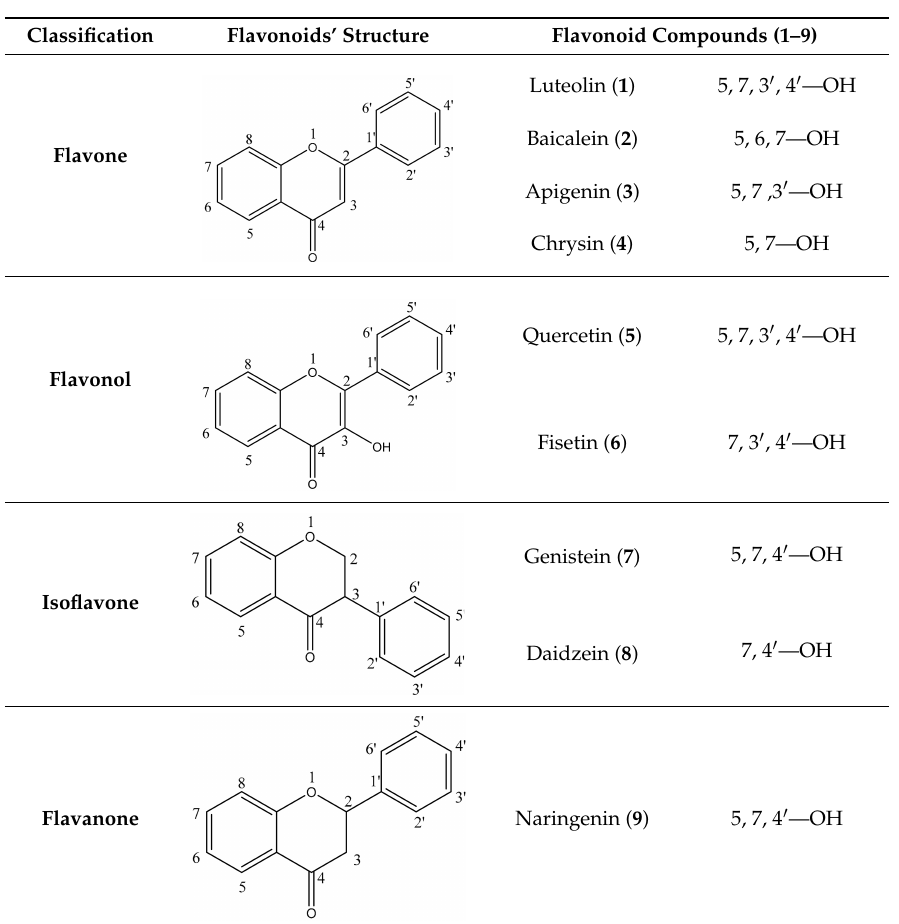
Table 1. The structures of the nine flavonoid